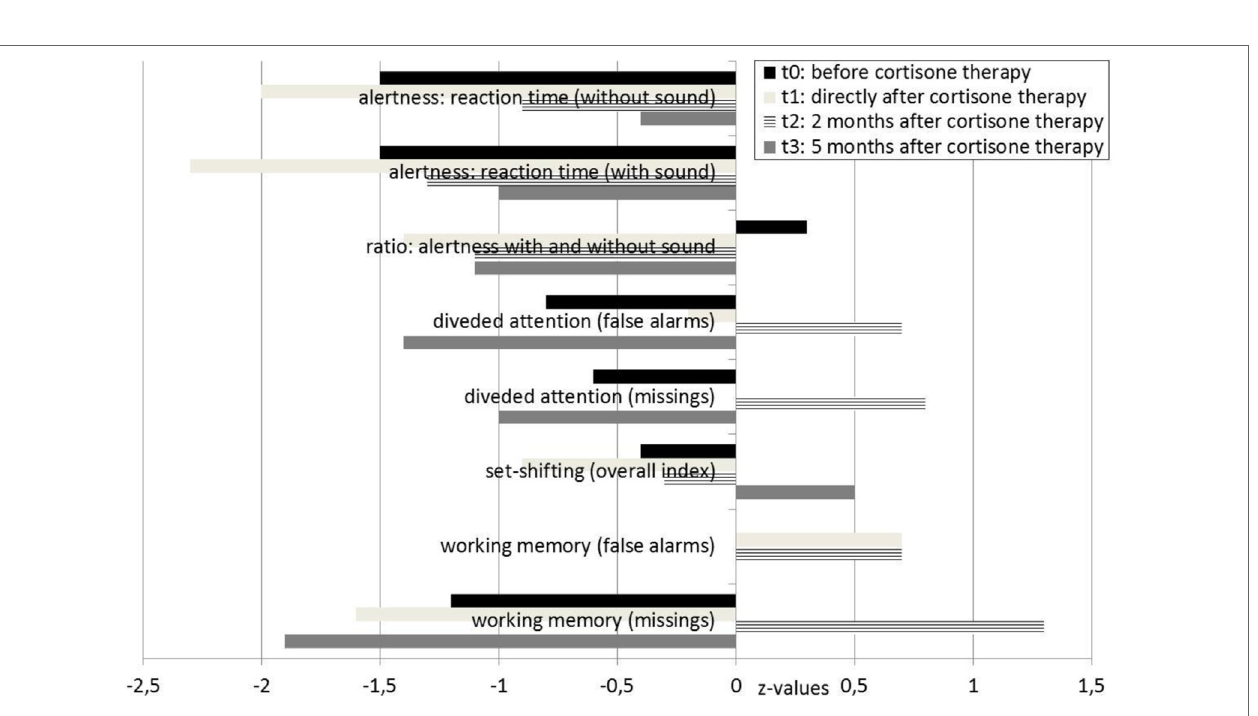
( Figure 2 ). The neuropsychological test of attentional